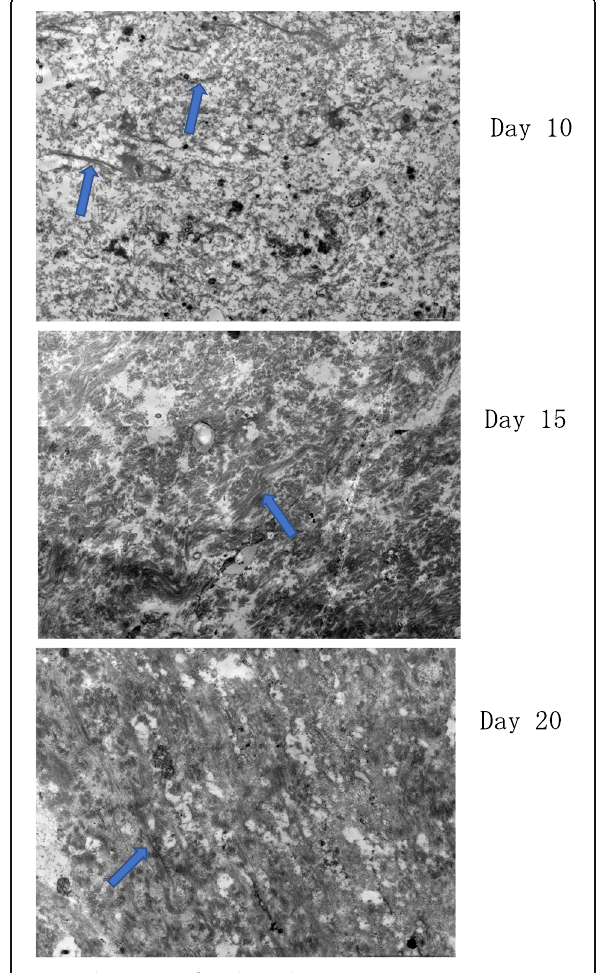
Fig. 5 Observation of tendon gel specimens using a transmission electron microscope. On day 10, the collagen fibers are thin and loose. On day 15, the collagen fiber becomes clear and denser. On the day 20, a stripe pattern peculiar to the collagen fibers are noted. Arrow: collagen fibers; scale bar: 2 μ